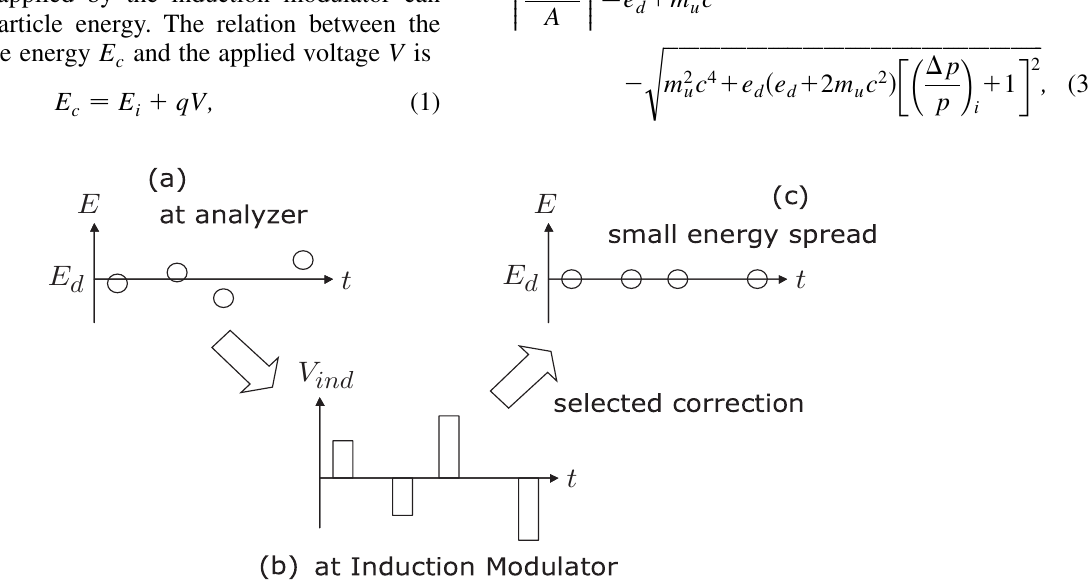
FIG. 1. Outline of selected momentum correction scheme. (a) At the analyzer the particle energy can be detected, (b) the induction modulator can apply the correction voltage, and (c) the particle energy is corrected one by one to the destination